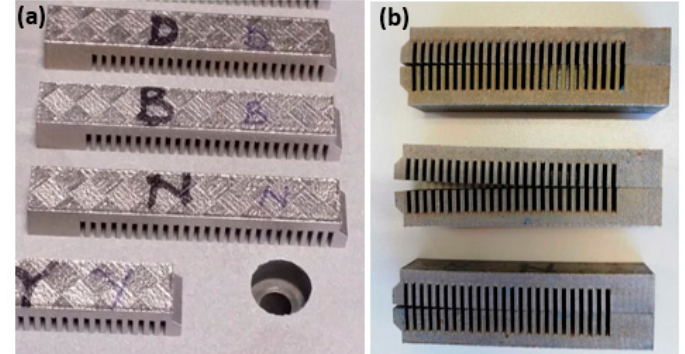
Figure 9. ( a ) Undistorted parts before separation from baseplate, and ( b ) distortion of parts relative to each other after separation from the baseplate.